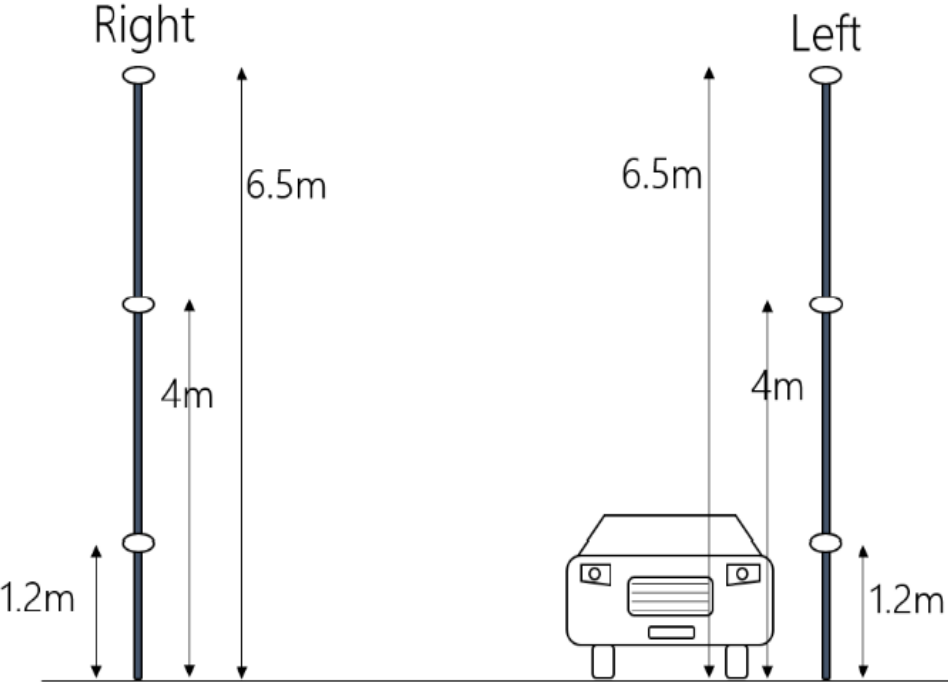
Figure 3. Measurement points in Figure 2 at three different heights.